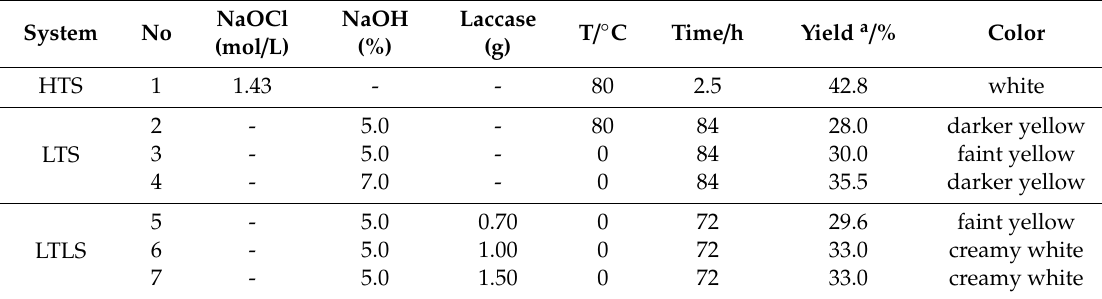
Table 1. Yield and color of products obtained using HTS, LTS and LTLS.